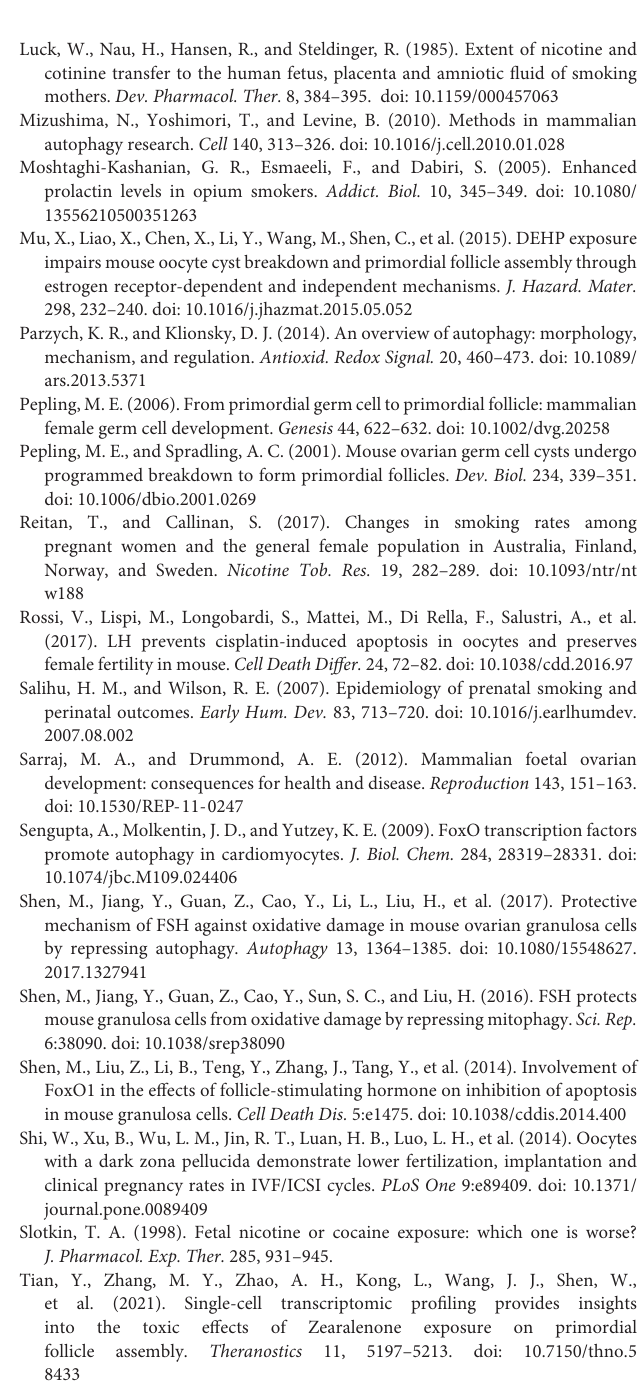
of MVH-positive oocytes (dark brown) in 21-day ovaries. (B) Representative IHC of the different classes of follicles. The primordial and primary follicle of a follicle containing an intact MVH-positive oocyte was surrounded by a single layer of flat or cuboidal granulosa cells; the secondary follicles were two or multiple layers of granulosa cells; and the antral follicle was a kind of follicle with a fluid-filled cavity adjacent to the oocyte. (C) Quantification of the number of total, primordial, primary, secondary, and antral follicles in 21-day ovaries ( n = 16 newborn female pups). The data are presented as means ± S.E. of three independent experiments (each in triplicate). ∗ P < 0.05, ∗∗ P < 0.01, and ns P >